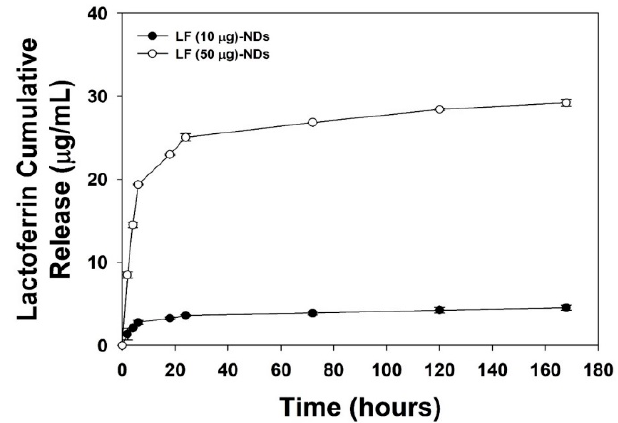
Figure 3. In vitro release profiles of LF from LF (10 μ g)-NDs and LF (50 μ g)-NDs for 7 days. ( n = 4) .